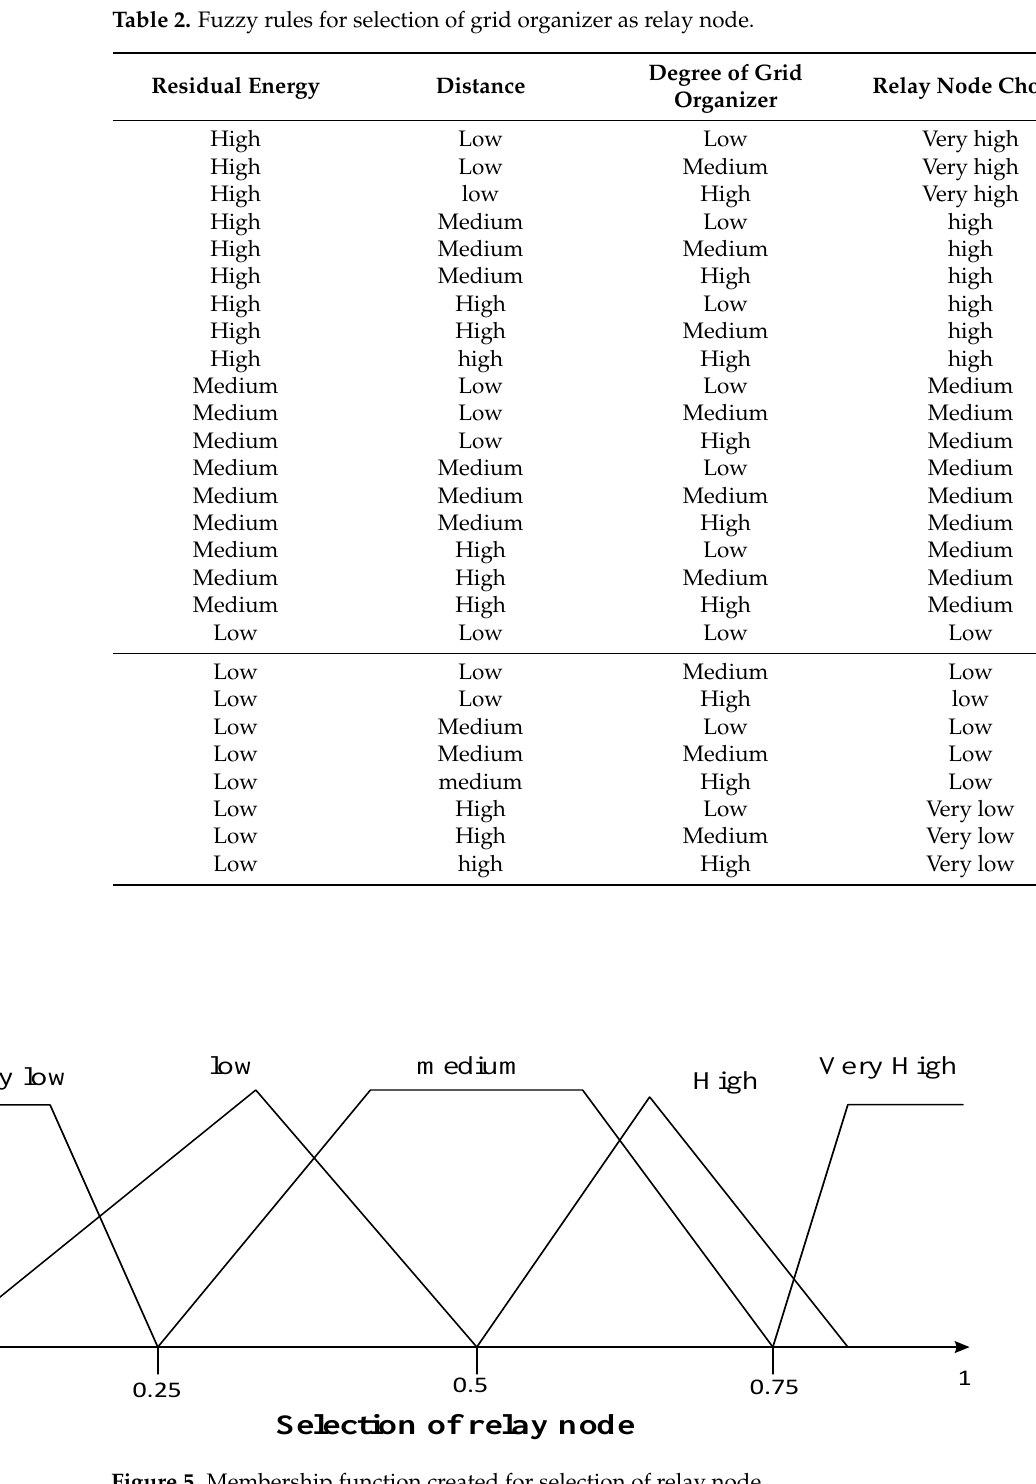
Figure 5. Membership function created for selection of relay node. Defuzzification